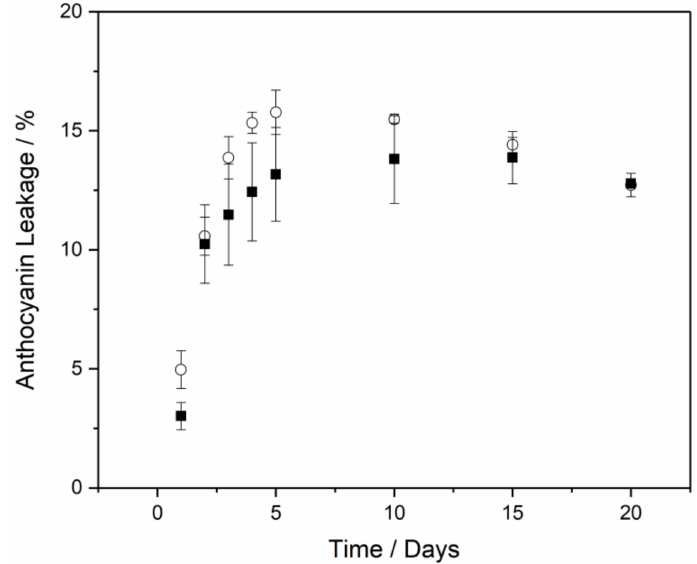
Figure 7. Anthocyanin leakage as a function of time, expressed as the amount (in %) of W 1 antho- cyanins located in the W 2 phase. Leakage for unmodified pectin emulsions is represented by open circles; amidated pectin results are represented by closed